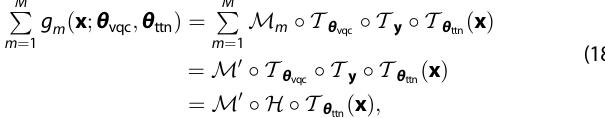
Fig. 7 The k th channel of TTN is equivalent to a feed-forward layer of neural network with the sigmoid function. The input x ½ k (cid:8) is derived from the reshape of X ½ k (cid:8) and goes through the feed-forward neural network with the weight matrix W ½ k (cid:8) and sigmoid function. The output y ½ k (cid:8) corresponds to the array for the k th order of ^ Y